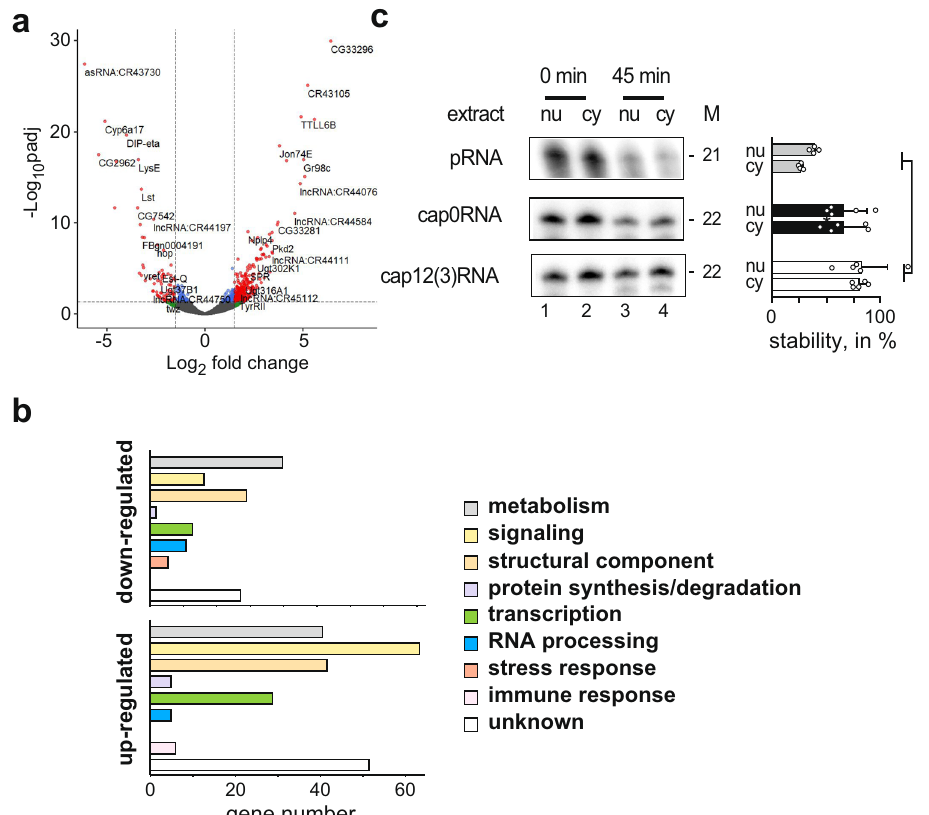
Fig. 3 Impact of mRNA cap-adjacent 2 ′ - O -ribose methylation on gene expression and RNA stability. a Volcano plot depicting differentially expressed genes in CMTr1 13A ; CMTr2 M32 double mutant fl ies compared to control fl ies. b Functional classi fi cation of upregulated (bottom) and downregulated (top) genes in CMTr1 13A ; CMTr2 M32 double mutant fl ies compared to control fl ies. c Incubation of monophosphorylated RNA (pRNA, gray) and capped RNA with (white) or without 2 ′ - O -ribose methylation of cap-adjacent nucleotides (black) in nuclear (nu) and cytoplasmic (cy) extracts from S2 cells. M: length in nucleotides. The graph to the right depicts the percent undegraded RNA left after 45 min as mean ± SE ( n = 5, except n = 4 for pRNA, p = 0.03 by one way ANOVA followed by Tukey ’ s test). Source data for gel and RNA stability values are provided as a Source Data fi